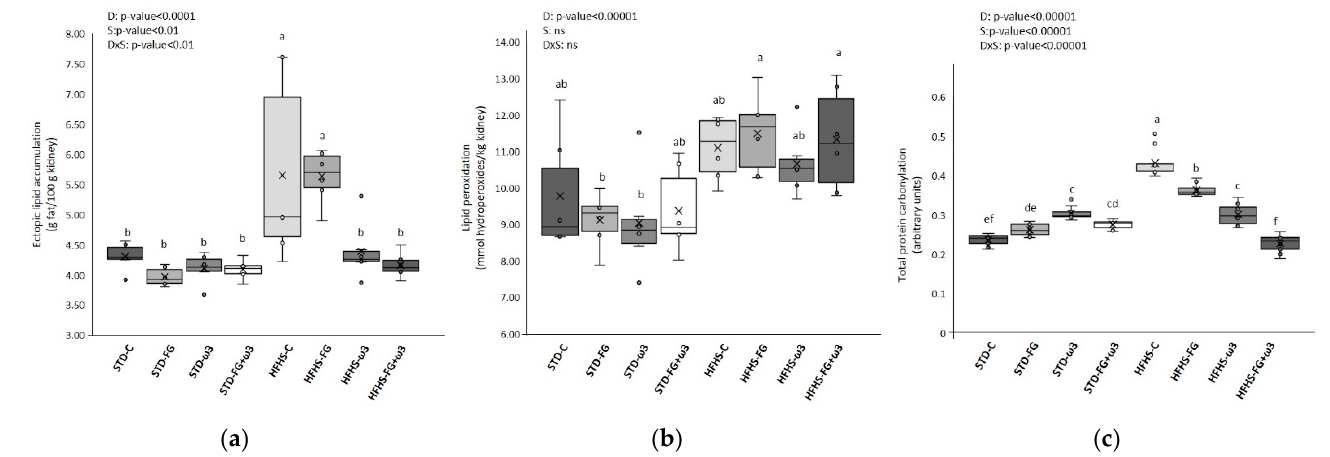
Figure 1. Effects of HFHS feeding and supplementation with fish oil and FG on: ( a ) ectopic lipid accumulation in kidney (g fat/100 g kidney); ( b ) lipid peroxidation levels in kidney (mmol hydroperoxides/kg kidney); ( c ) total protein carbonylation levels in kidney (arbitrary units) (data obtained from the analysis of the gels shown in Figure S1). Results were analyzed by two-way ANOVA for background diet effect (D: STD and HFHS), supplement effect (S: CONTROL, FG, ω -3, FG + ω -3), and interaction between diet and supplement (DxS), followed by Tukey HSD’s post hoc test. Data are presented as means ± SD (n = 9). Different superscripts indicate significant differences ( p < 0.05) (analyzed by post hoc Tukey HSD). ns = no significant.